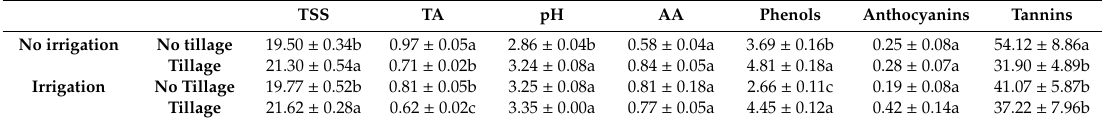
Table 2. E ff ects of irrigation and tillage on the Chardonnay cultivar on grape total soluble solids (TSS: Brix), titratable acidity (TA: % tartaric acid), pH, ascorbic acid (AA: mg 100 mL − 1 grape juice), total phenols (gallic acid equivalent: GAE 100 g − 1 Fw), anthocyanins (mg cyn-3-glu 100 g − 1 Fw) and tannins (mg 100 mL − 1 grape juice).